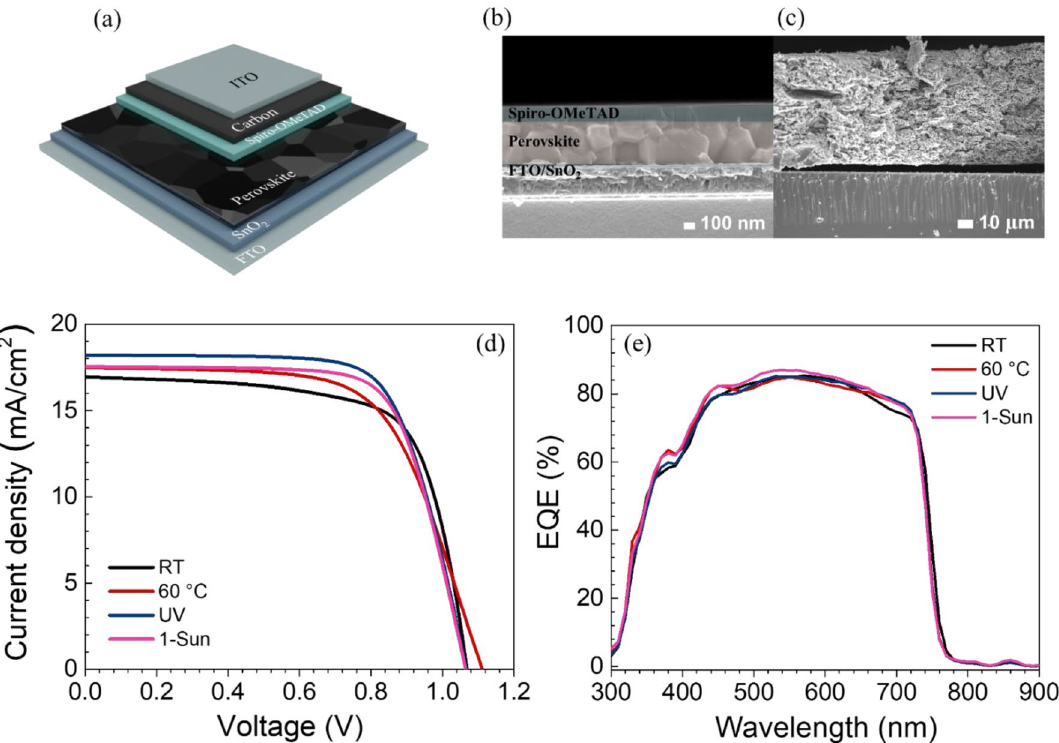
Figure 6. ( a ) Illustration of carbon-based perovskite solar cell. ( b ) Cross-sectional SEM images of perovskite solar cell with ( c ) carbon-based back-electrode. ( d ) J-V curves of different perovskite solar cells with carbon electrode. ( e ) EQE